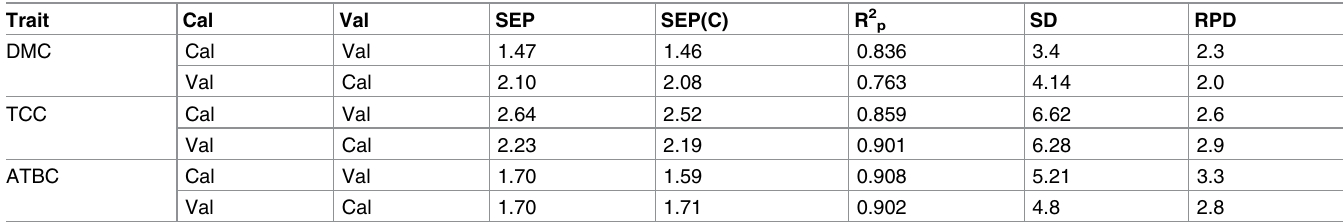
Table 8. Independent validation of models for DMC, TCC and ATBC.